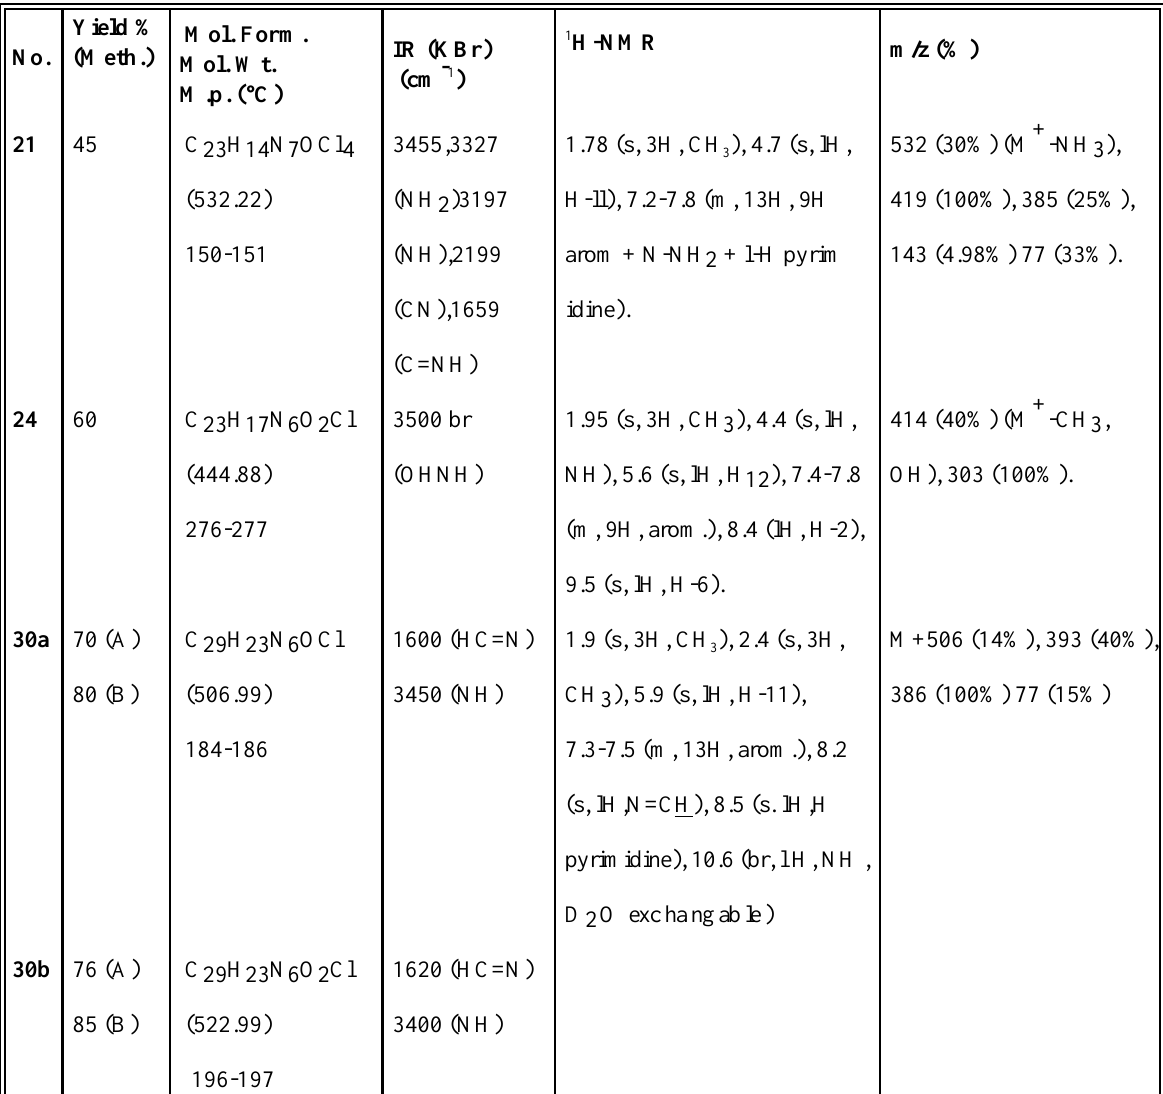
Table 1 Cont. Yield % No. (Meth.)